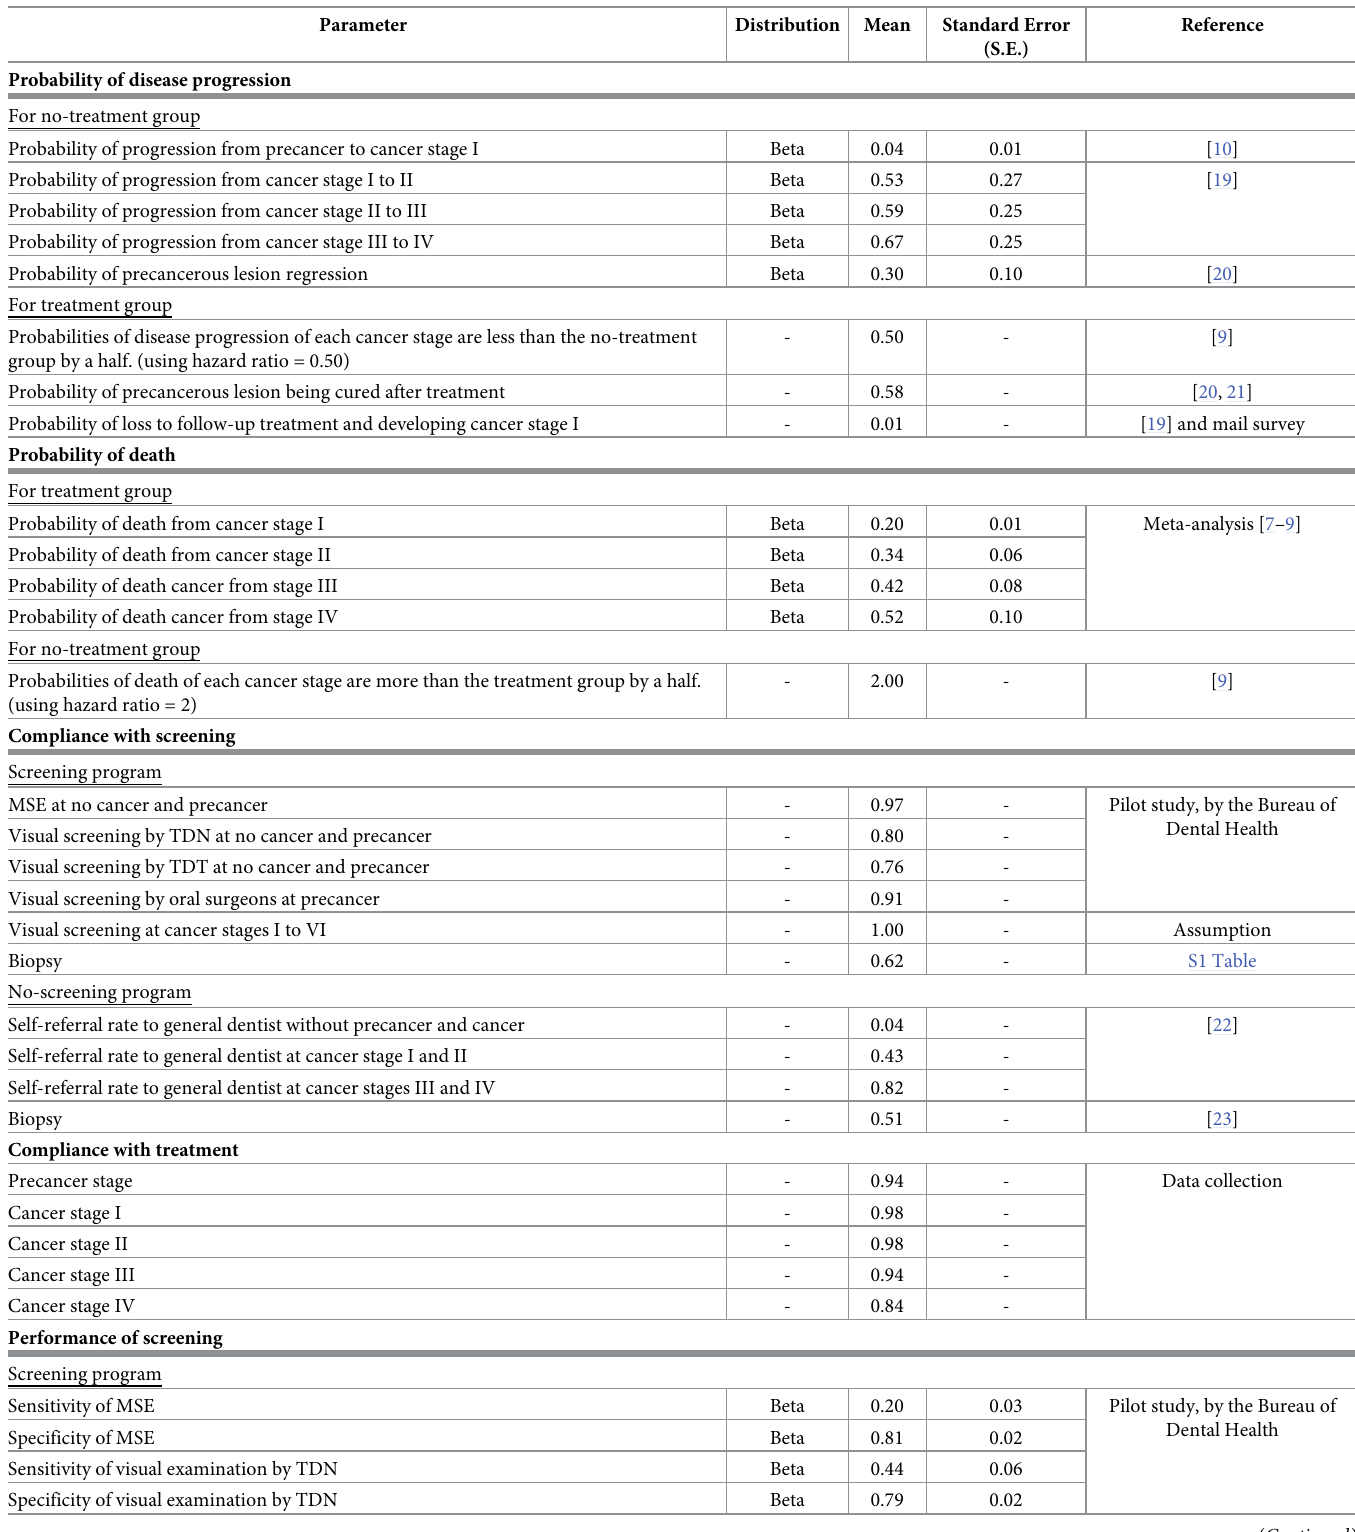
Table 1. Summary data and